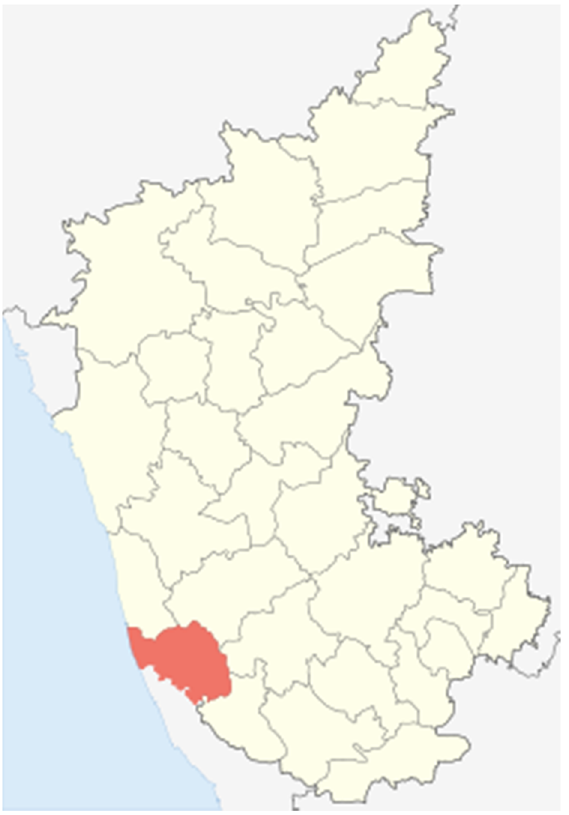
Fig 2. Map of Karnatakawith Dakshina Kannada district (highlighted) [Images available from: https:// en.wikipedia.org/wiki/Dakshina_Kannada].